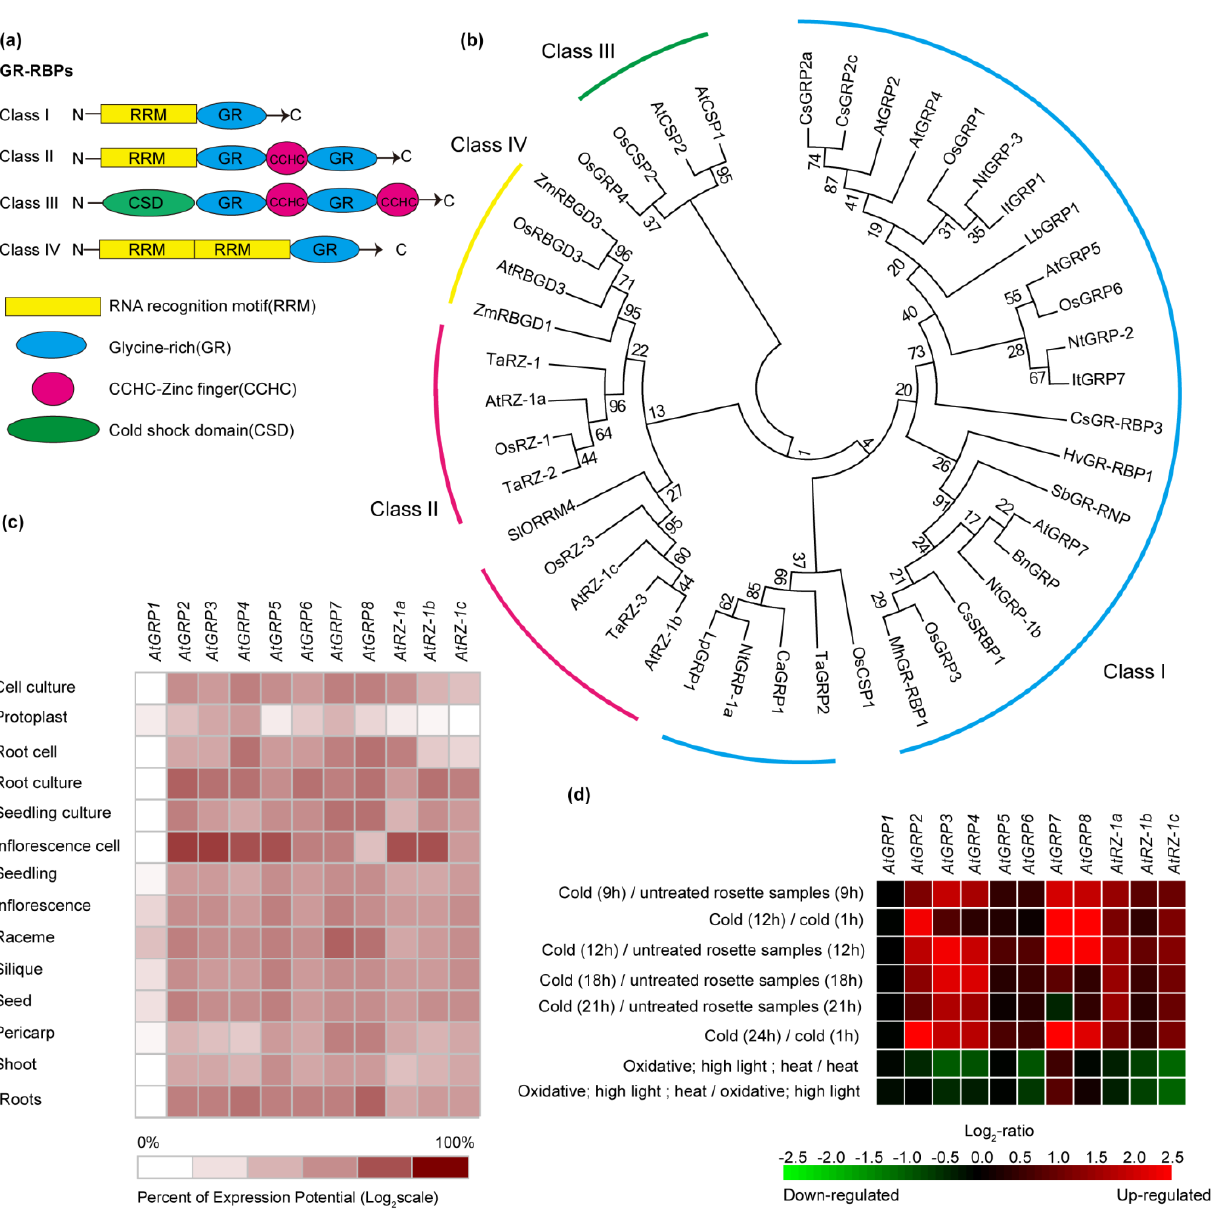
Figure 1. ( a ) Schematic representation of domain structures in plant glycine-rich RNA-binding proteins (GR-RBPs). Members of class I have an RNA recognition motif (RRM) at the N-terminus and a glycine-rich region at the C-terminus. Class II proteins, which are also called zinc finger-containing glycine-rich RNA-binding proteins (RZs), contain an RRM and a glycine-rich region separated by a CCHC-type zinc finger motif. Members of class III have an N-terminal cold shock domain (CSD) and a C-terminal glycine-rich region with two or more zinc finger motifs while class IV proteins have two RRMs and a glycine-rich region at the C-terminus. ( b ) Phylogenetic tree based on the alignment of protein sequences of GR-RBPs from sixteen plant species. These GR-RBPs are divided into four subclasses (denoted I – IV). Phylogenetic analyses were conducted in MEGA5. Species names are abbreviated as follows: Sl, Solanum lycopersicum ; Bn, Brassica napus ; Nt, Nicotiana tabacum ; At, Arabidopsis thaliana ; Cs, Camelina sativa ; Ca, Capsicum annuum ; Sb, Sorghum bicolor ; Mh, Malus hupehensis ; Hv, Hordeum vulgare ; Cs, Cucumis sativa ; Ca, Capsicum annuum ; Os, Oryza sativa ; Lp, Lolium perenne ; Lb, Limonium bicolor ; Ta, Triticum aestivum ; It, Ipomoea trifida . ( c ) Expression profile of GR-RBPs in different tissues of Arabidopsis thaliana . ( d ) Expression profile of GR-RBPs from Arabidopsis thaliana under different treatments.